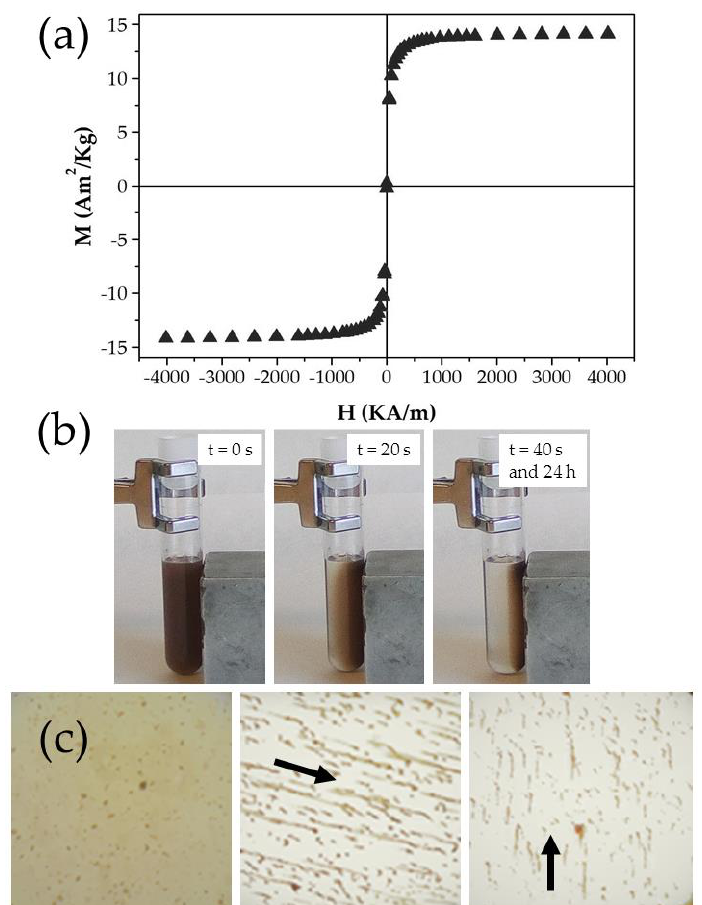
Figure 9. ( a ) Hysteresis cycle of the Fe 3 O 4 /PCL NPs (of 2:4 Fe 3 O 4 :PCL weight ratio, ▲ ); ( b ) visual observation of an aqueous dispersion (0.5%, w / v ) of these particles on a 400 mT permanent magnet (located close to the right lateral flat surface of the glass vial), and ( c ) optical microphotographs of the aqueous colloids under the influence of this magnetic field (in the direction of the arrow).